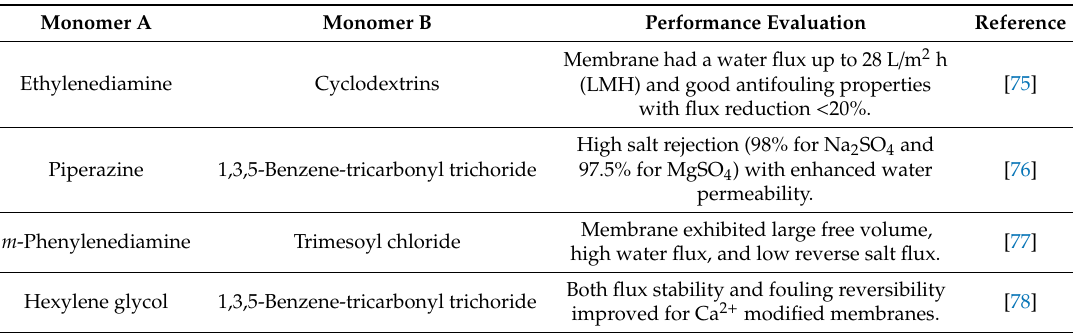
Figure 4. Mechanism of interfacial polymerization. Table 3. Monomers and performance evaluation for thin-film composite (TFC) membranes prepared by interfacial polymerization